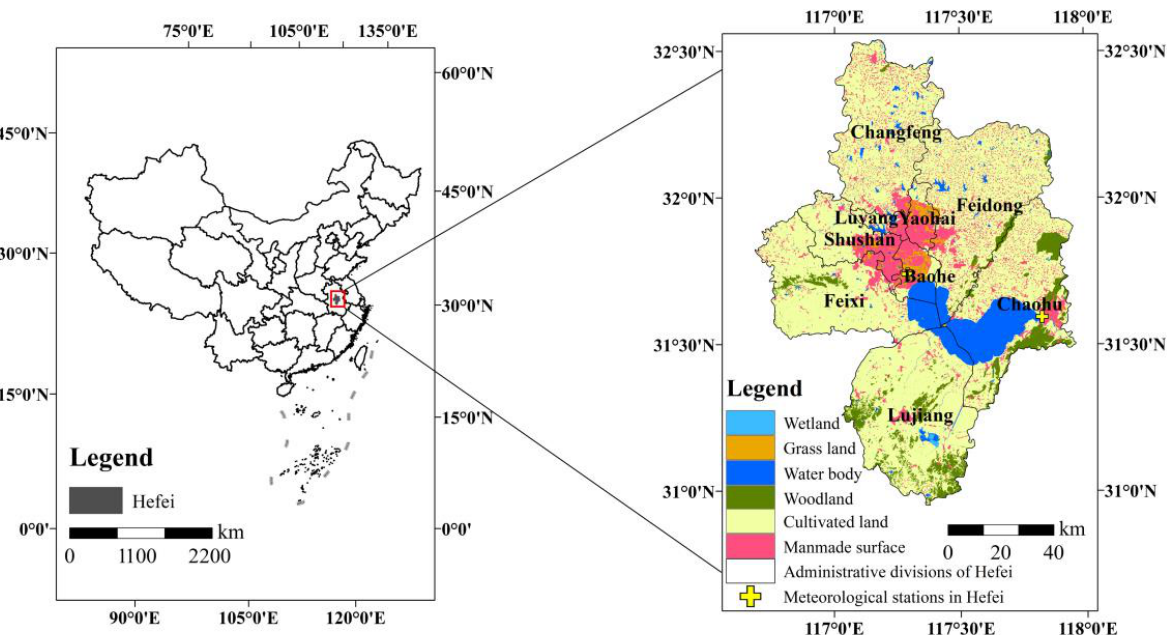
Figure 1. 1 km pixel scale land-use types for Hefei (approximately 127 km × 178 km) in 2020.